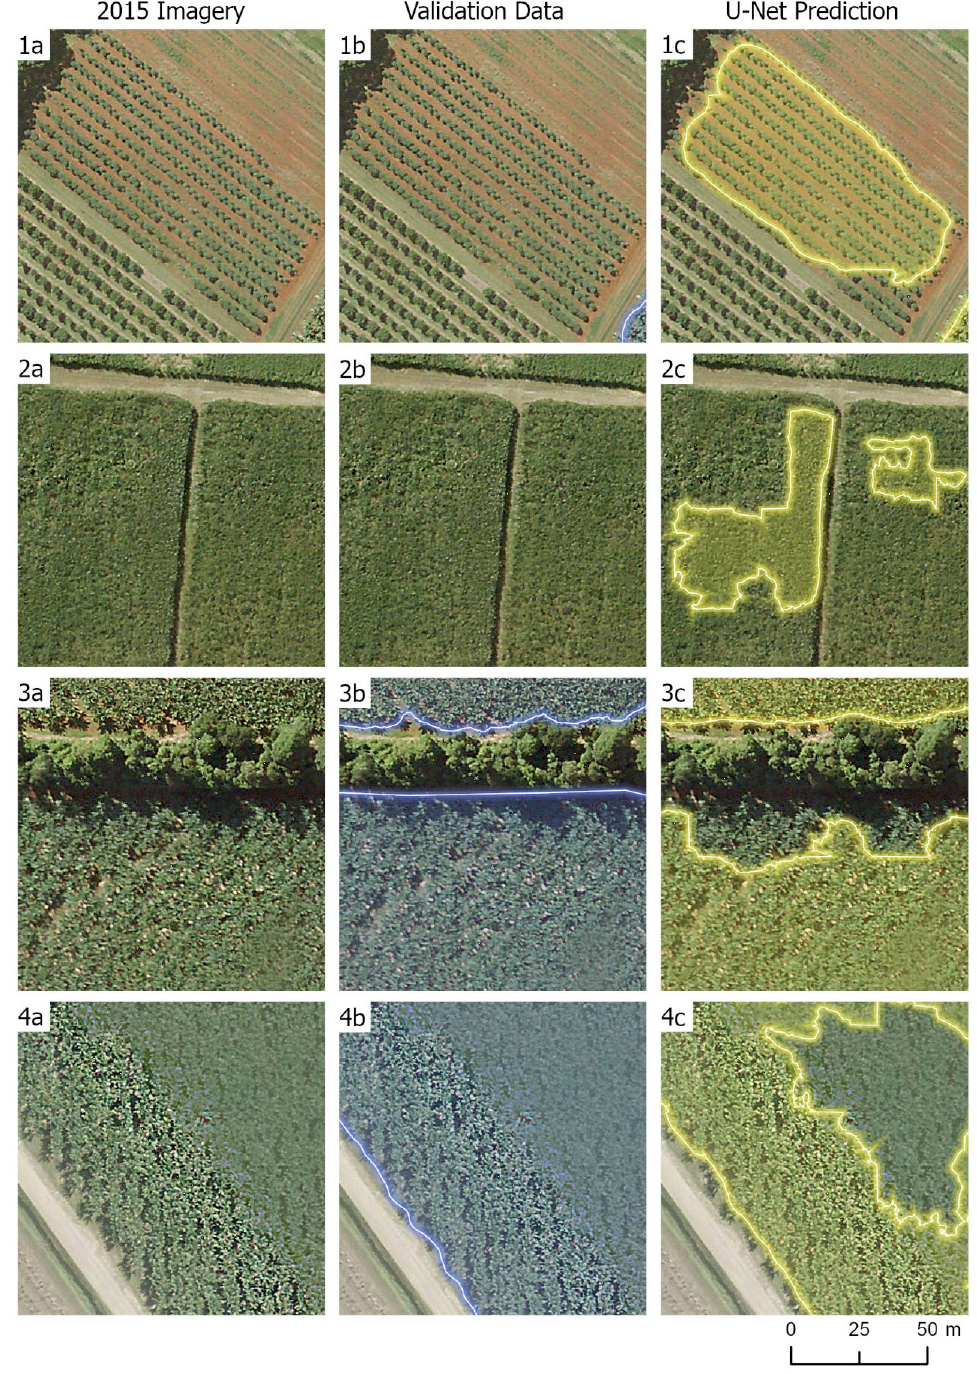
Figure 7. Examples (1–4) show incorrectly classified areas of banana plantations for the U-Net classification. The left column ( a ) shows the three-band true-color aerial photography. The middle column ( b ) shows the validation data and the right column ( c ) shows the output U-Net